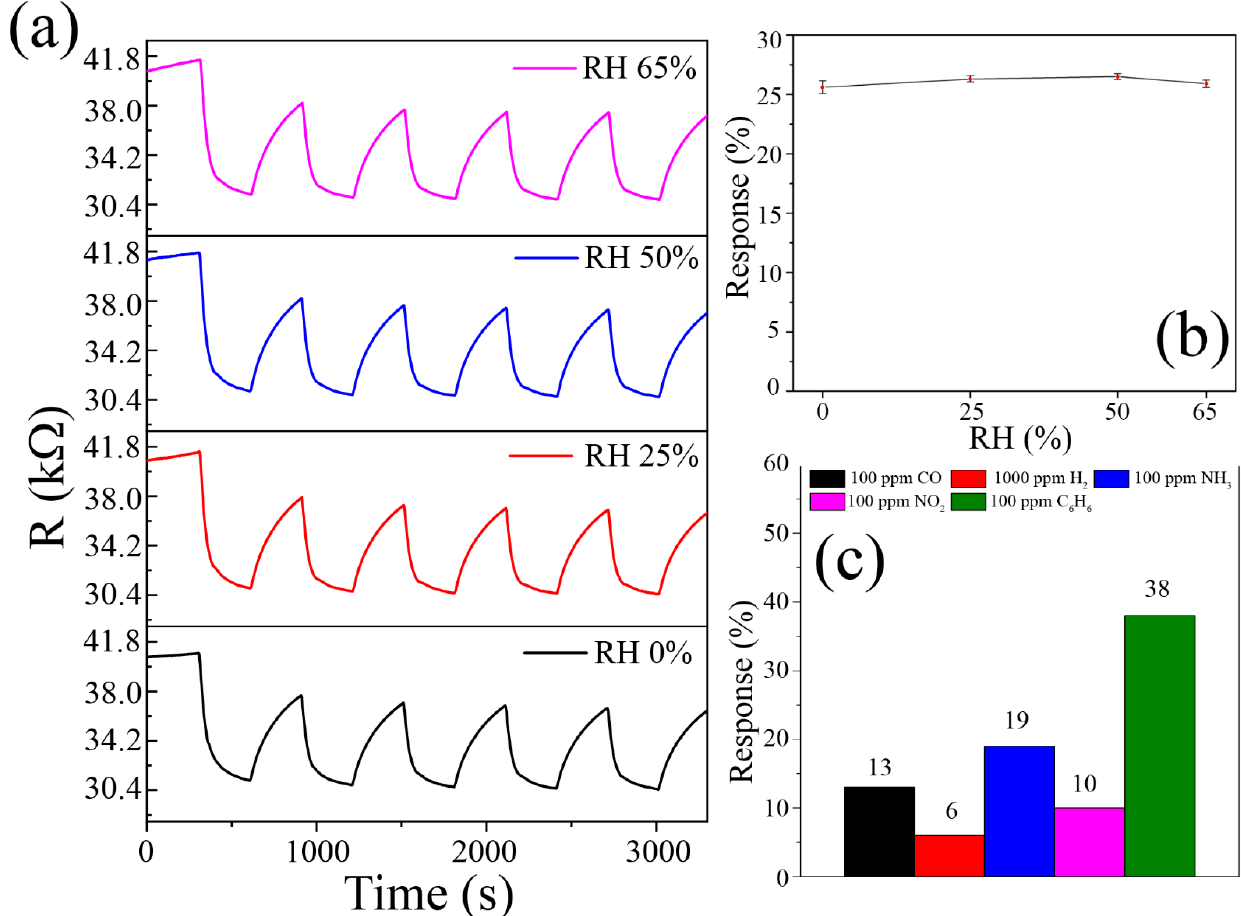
Figure 8. Experimental curves of resistance change upon sensing 20 ppm of benzene at varying relative humidity ( a ); Dependence of sensing response to 20 ppm of benzene from relative humidity ( b ); Selectivity diagram: sensing responses to various analyte gases at 300 °C ( c ).